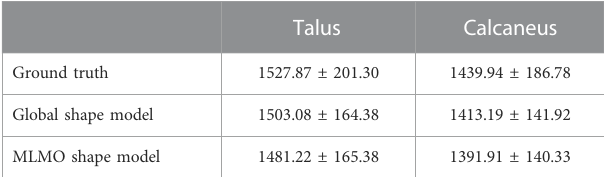
TABLE 1 Coverage area measurements ( μ ± σ in mm 2 ) of the subtalar